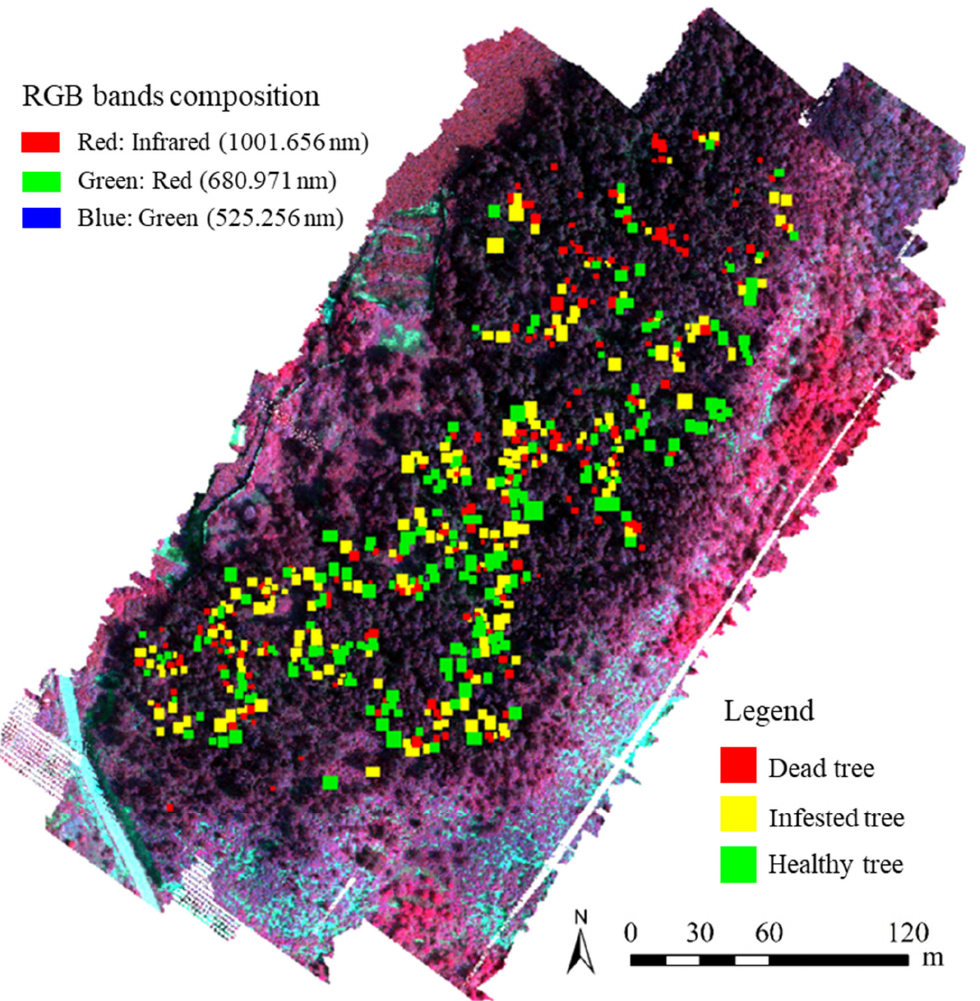
Figure 5. Standard false ‐ color image of the stand and distribution of sample trees. Table 2. Spectral vegetation indices (SVIs) used in the study. Index Formulation or Depiction Bands